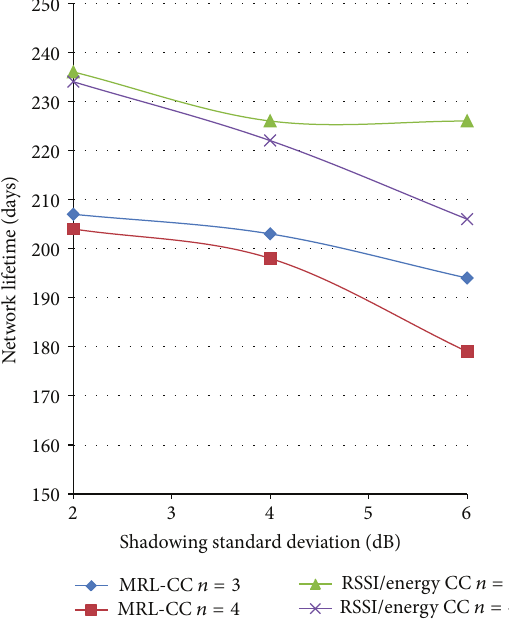
Figure 14: Network lifetime (architecture C) for different number of path losses, 𝑛 , and different shadowing standard deviation, for the MRL-CC and the RSSI/energy